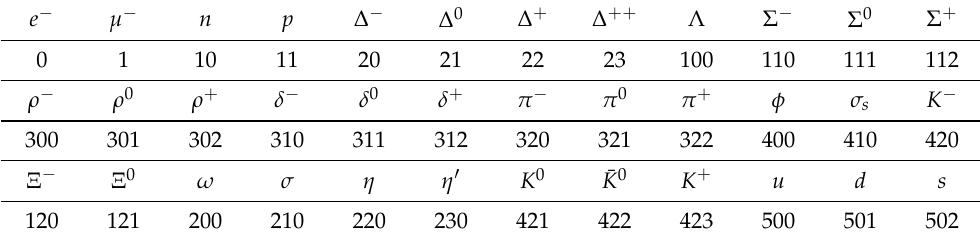
Table 1. Particle